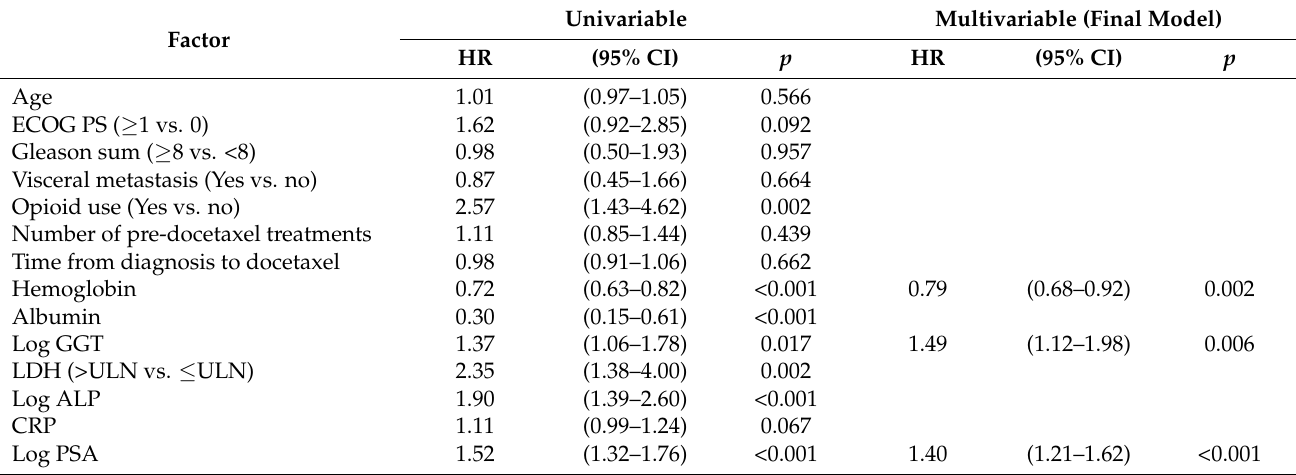
Figure 1. Relationship between Log GGT and adjusted HR for OS as visualized by splines with three knots located at the 25th, 50th, and 75th percentiles (adjusted to hemoglobin and Log PSA). CI, confidence interval; GGT, γ -glutamyltransferase; HR, hazard ratio; OS, overall survival; PSA, prostate-specific antigen. Table 2. Univariable and multivariable analyses for OS in 107 mCRPC men treated with docetaxel.